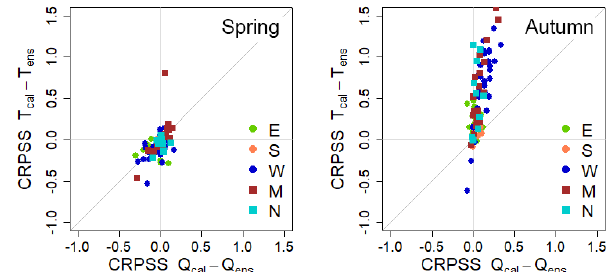
Figure 5. Difference in CRPSS for uncalibrated and calibrated tem- perature for spring and autumn. The difference in temperature skill is plotted on the y axis and the difference in streamflow skill on the x axis. The grey diagonal represent the 1 : 1 line. Catchment values are color indexed by region. All plots are presented for a lead time of 5